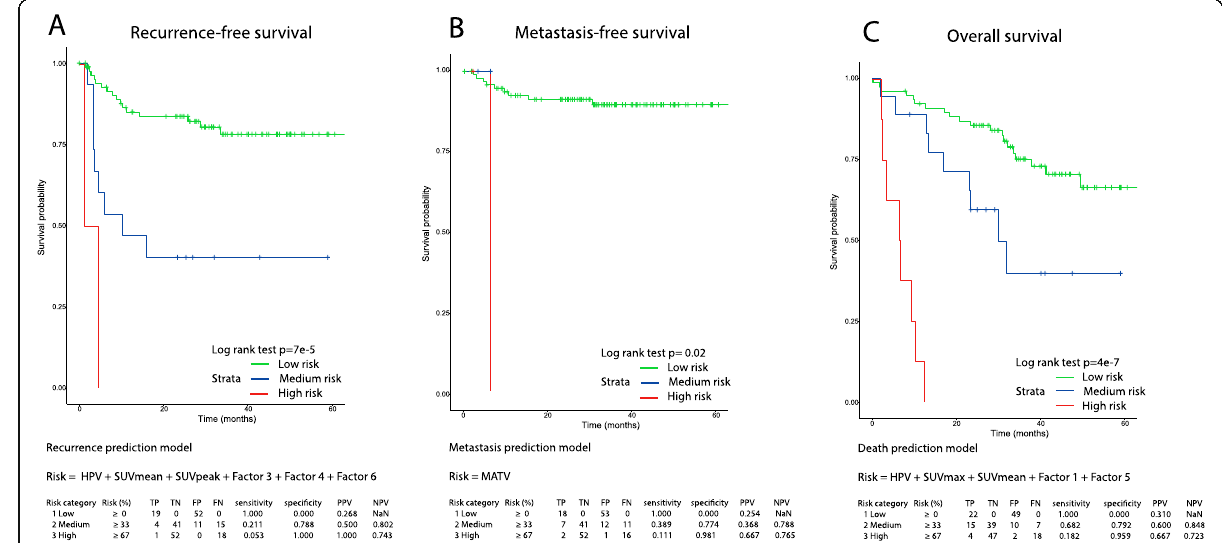
Fig. 3 The accuracy of th e c ombined prediction of a locoregional recurrence, b metastasis, and c overall survival in the validation cohort. In b , the curve of the relatively small medium risk group for metastasis is short; this is due to the short follow-up time until the metastasis occurred. A significant predictive risk stratification ( p < 0.05) was shown, divided in low (0 – 33%), medium (33 – 66%), and high (66 – 100%) risk for an unfavorable